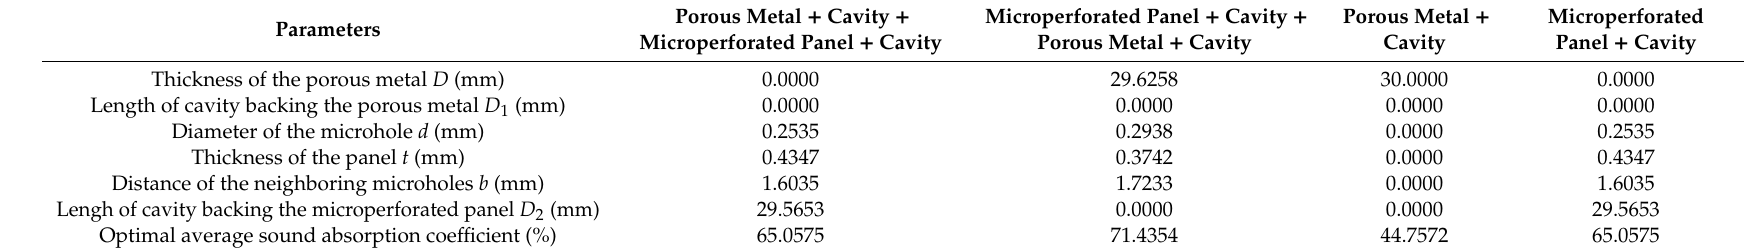
Table 1. The obtained optimal structural parameters when the limited total thickness was 30 mm.